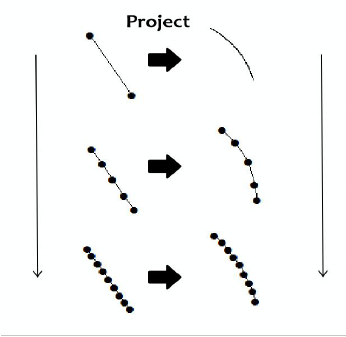
Figure 1. Densely resampling